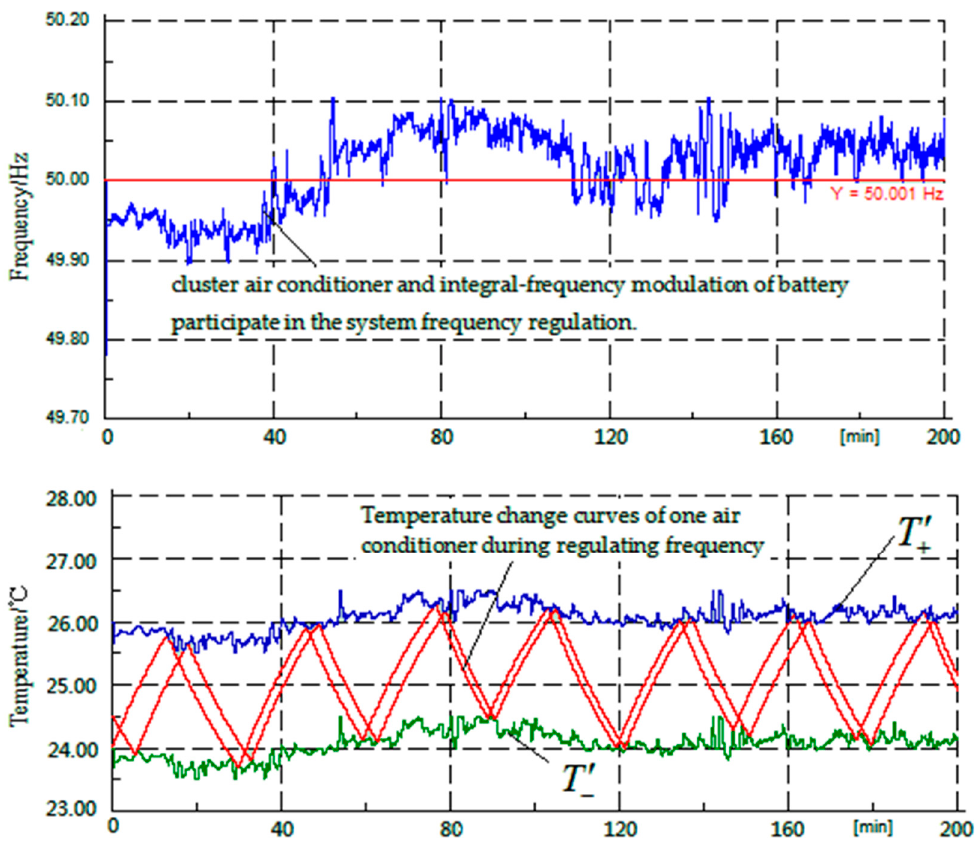
Figure 9. The system frequency curve and the temperature change curves of one air conditioner during the frequency regulation.